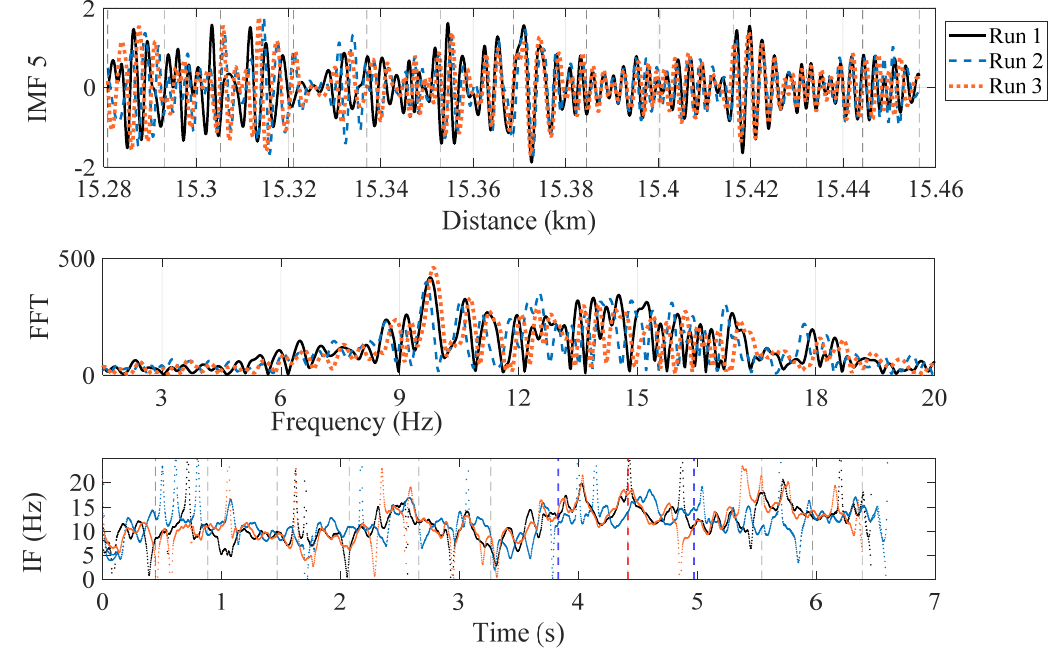
Figure 9. IF-5 and FFT calculated from IMF 5 (showing a range of frequencies closer to the spans natural frequencies) (red dashed line = replaced pier; blue dashed lines = boundary between the new and the other spans).